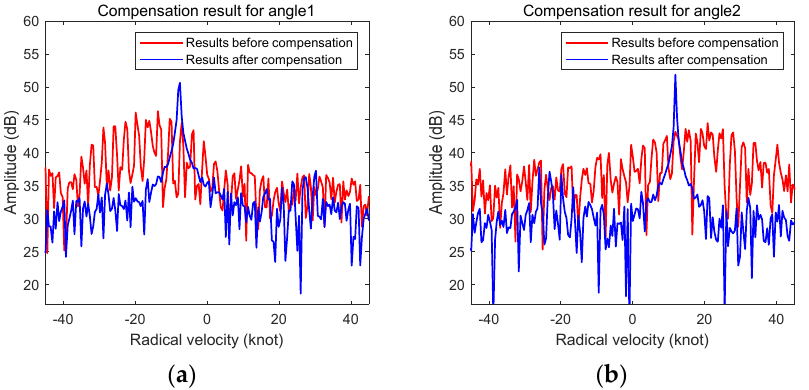
Figure 16. Compensation result for case of uniform deceleration motion: ( a ) compensation result for angle1, ( b ) compensation result for angle2.